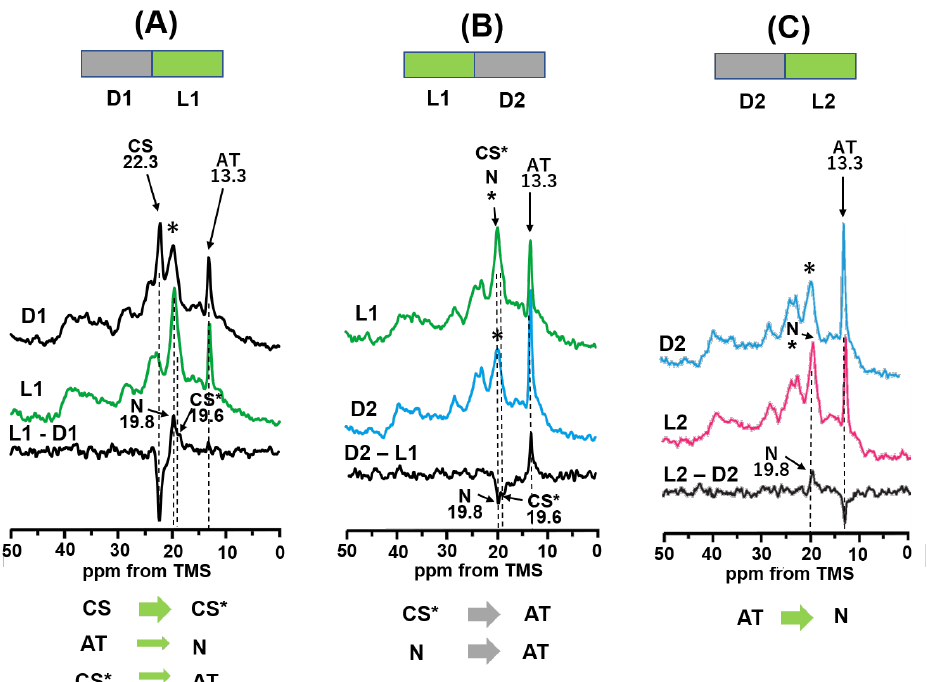
Figure 3. ( A ) Photo reaction pathway of [20- 13 C]retinal-WT-BR under green light (520 nm) illumina- tion at − 20 ◦ C. 13 C CP-MAS NMR spectra were recorded in the dark (D1; 20- 13 C) and subsequently under green light (L1; 20- 13 C), and the difference in spectra between L1 and D1 (L1-D1; 20- 13 C) indicated that the CS state changed to the CS* intermediate. ( B ) Photoreaction pathway in the dark after green light illumination at − 20 ◦ C. 13 C CP-MAS NMR spectra were recorded under green light (L1; 20- 13 C) and subsequently in the dark after L1 (D2; 20- 13 C), and the difference in spectra between the D2 and L1 spectra (D2-L1; 20- 13 C) indicated that the CS* intermediate changed to the AT state. ( C ) Photoreaction pathway under green light illumination at − 20 ◦ C after the D2 state. 13 C CP-MAS NMR spectra were recorded in the dark (D2; 20- 13 C) after L1 and subsequently under green light (L2; 20- 13 C), and the difference in spectra between L2 and D2 (L2-D2; 20- 13 C) indicated that the AT state changed to the N